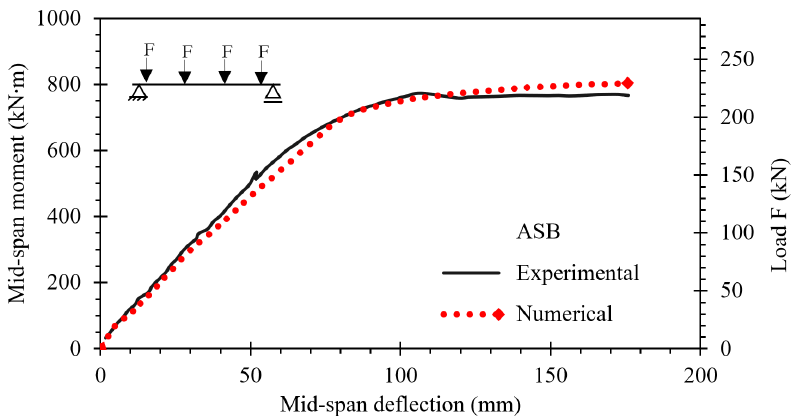
Figure 15. Asymmetric Slimflor Beam